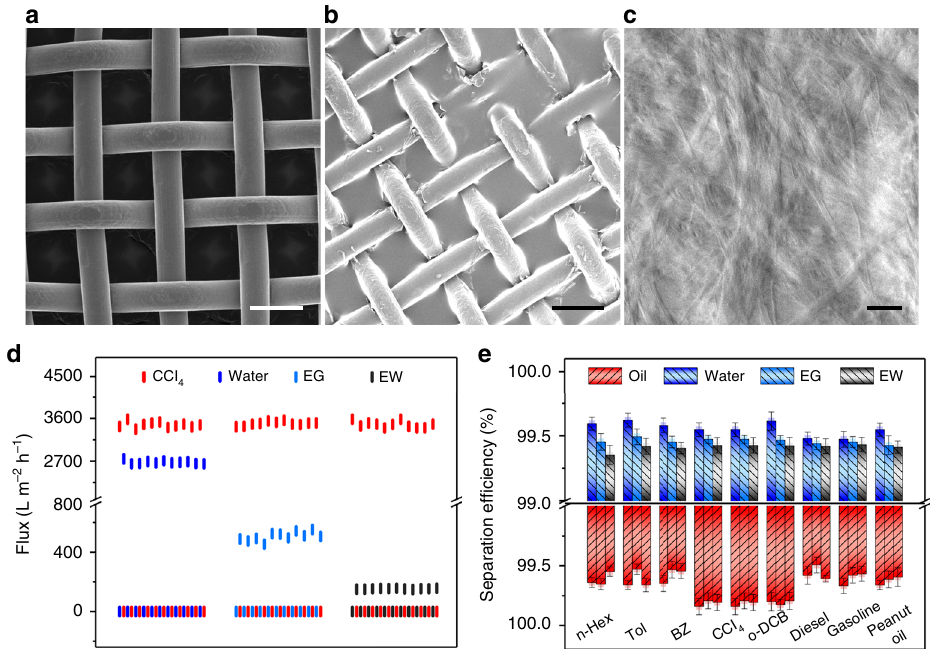
Fig. 4 Characterization of (TBP) 4 SiW@BCB gel membrane and separation property. a – c SEM images of ( a ) blank stainless-steel mesh, ( b ) gel membrane coating, and ( c ) local ampli fi cation. d – e column plots of ( d ) fl ux plots and ( e ) separation ef fi ciency of some immiscible liquid pairs encountering over 10 reversible transformation cycles under gravity, where EG: ethylene glycol, GW: glycerin water solution (67.7%), n-Hex: n-hexane, o-DCB: o- dichlorobenzene, Food oil: peanut oil. Data are collected to get average values ( n = 5). Scale bars, 50 μ m ( a , b ), 2 μ m ( c ). Source data are provided as a Source Data fi